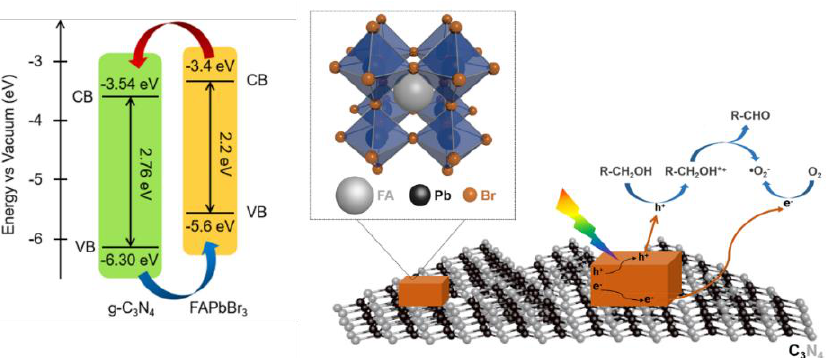
Figure 6. Schematic illustration of photo-catalytic reaction occurring on FAPbBr 3 /C 3 N 4 hybrids.